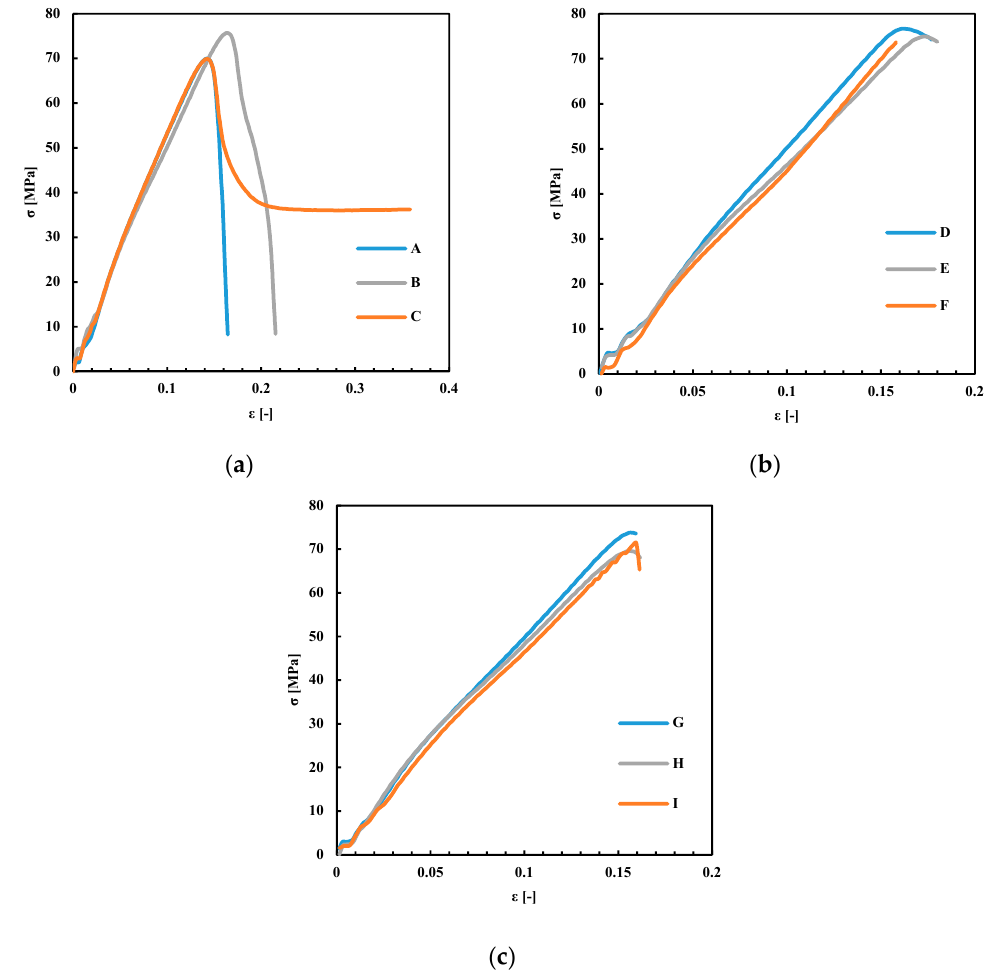
Figure 8. Stress–strain plots for the specimens obtained by FDM with different T b . ( a ) T n = 180 °C; ( b ) T n = 200 °C; ( c ) T n = 230 °C. A,D,G: T b = 70 °C; B,E,H: T b = 90 °C; C,F,I: T b = 110 °C. Table 3. Experimental results of tensile tests performed on specimens listed in Table 1 ( σ M is the tensile strength, ε is the tensile strain at the tensile strength, ε t is the total extension achieved at the test end). Sample